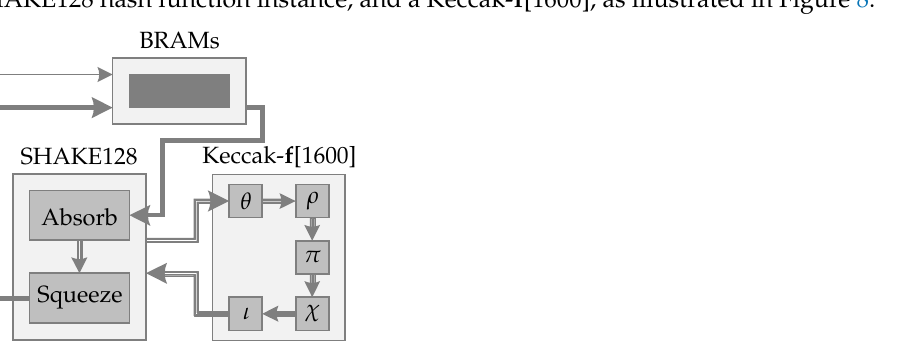
Figure 8. Block diagram representation of the SHAKE128 hash function. Thin line represent 32-bits buses, thick line represent 64-bits buses, and double lines represent 1600-bits buses. Control signals have been omitted.